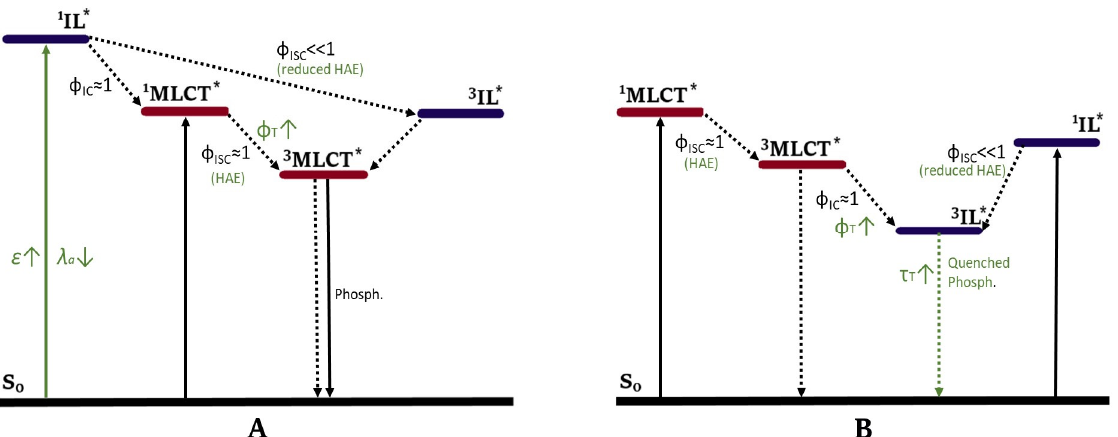
Figure 8. Energy level diagrams describing the photophysical processes of TM PSs with a visible light-harvesting ligand [25]. ( A ) Energy diagram for attaining strong absorption in the visible range. E( 3 IL) > E( 3 MLCT) [93] ( B ) Energy diagram for attaining a long-lived 3 IL state. E( 3 IL) < E( 3 MLCT) [94]. For both diagrams the transition 1 MLCT → 3 MLCT is more efficient due to the HAE and the transition 1 IL → 3 IL is less efficient due to a reduced HAE. The excited state is denoted by a *.